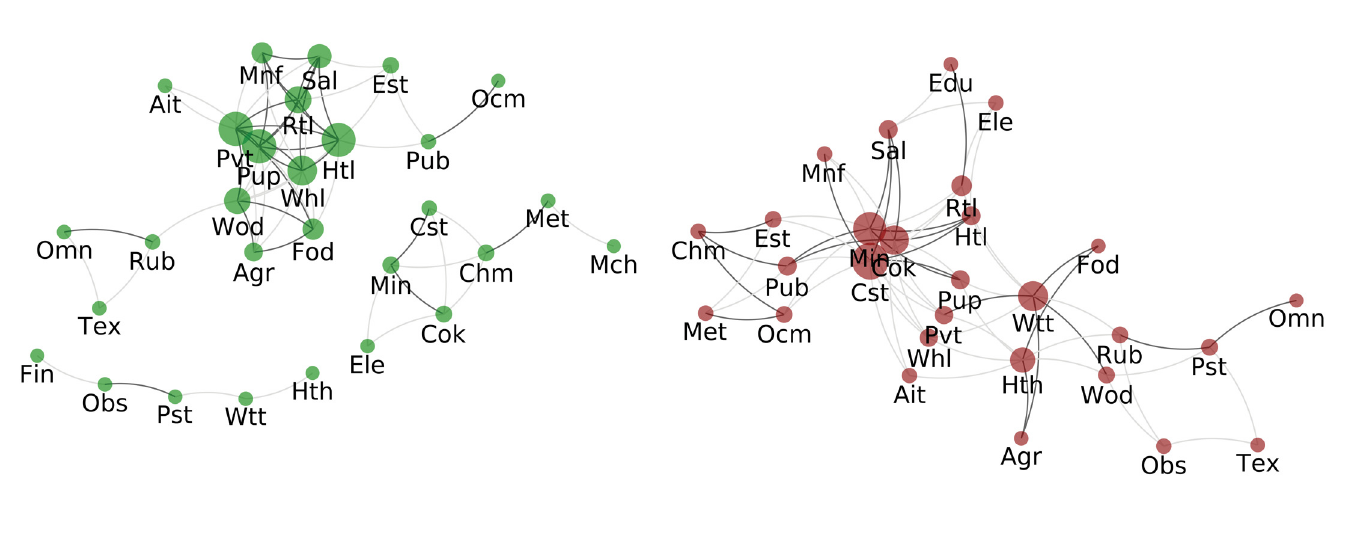
Fig 7. Correlation of Sectors’ Pagerank. Left: Correlatedsectors - Two sectors are connectedwith a dark grey link if the Pearson coefficient betweentheir ¼ 0 : 88 if the coefficient is only above T þ ¼ 0 : 79 the link is light grey. Right: Anticorrelated countries - Two sectors are PageRank time series is above T þ 1 0 ¼ (cid:0) 0 : 87 if the coefficientis only below T (cid:0) ¼ (cid:0) 0 : 79 the link is light connectedin dark grey if their PageRanktime series have a Pearson coefficient below T (cid:0) 1 0 grey. In both the size of of the nodesis proportional to the strength of the node (regarding light